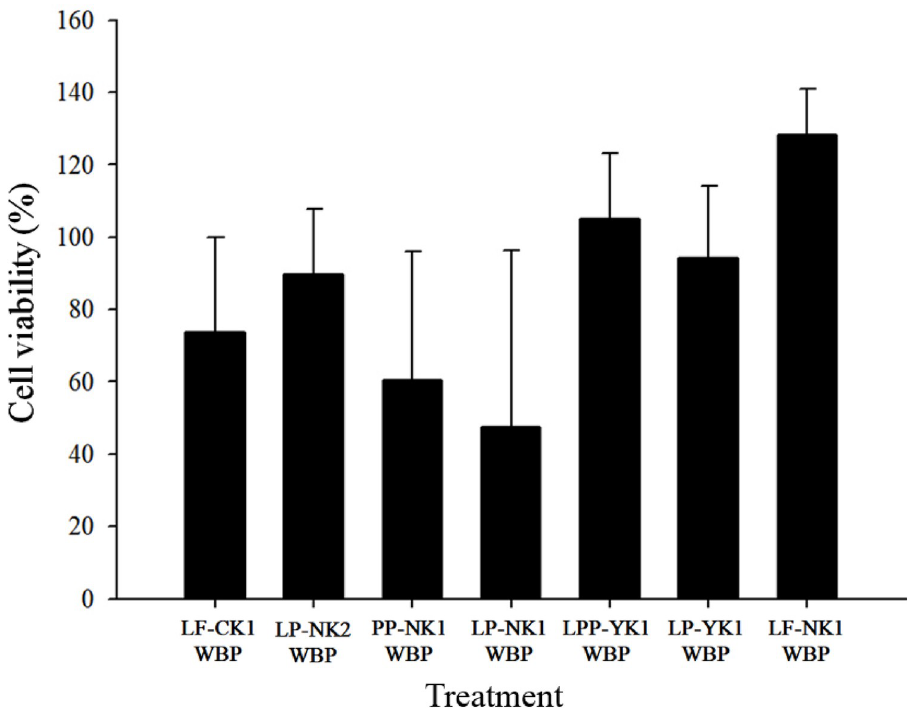
Fig 1. Viability of HT-29 cells treated with whey bioconversion products (WBPs) (OD 540 ). LF-CK1 WBP: WBP prepared with L . fermentum SMFM2017-CK1, LP-NK2 WBP: WBP prepared with L . plantarum